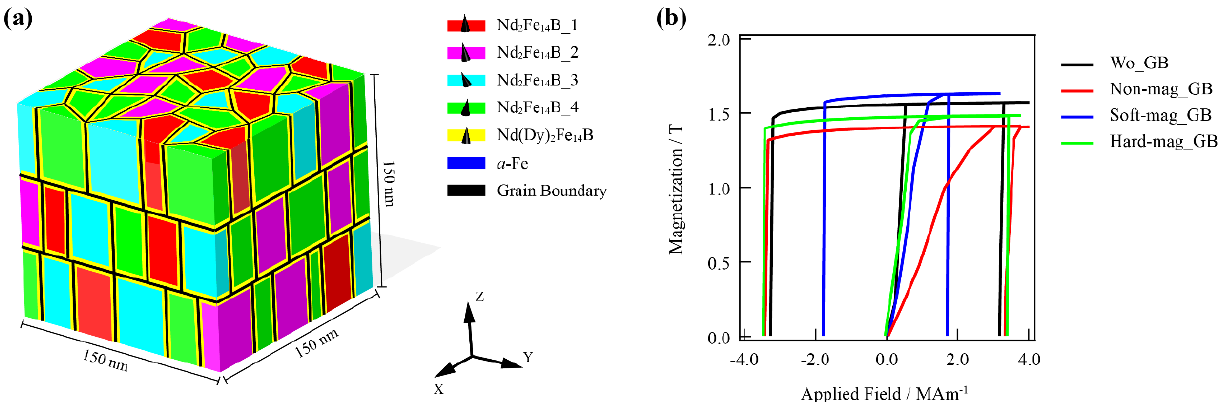
magnetic moment, unit vector, external field, demagnetic field, anisotropic constant, and exchange constant, respectively. For the simulated models to be more similar to real magnets, the characteristics of polyhedral grains, an independent orientation for each grain, a core-shell structure, and grain boundaries were modeled as illustrated in Figure 3a. The reference micromagnetic